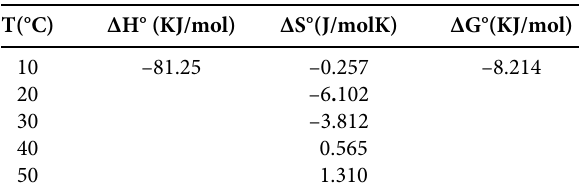
Table 4. Thermodynamic parameters of Cr(VI) sorption onto isatin based Amberlite XAD-2 resin T(°C) ∆H° (KJ/mol) ∆S°(J/molK)